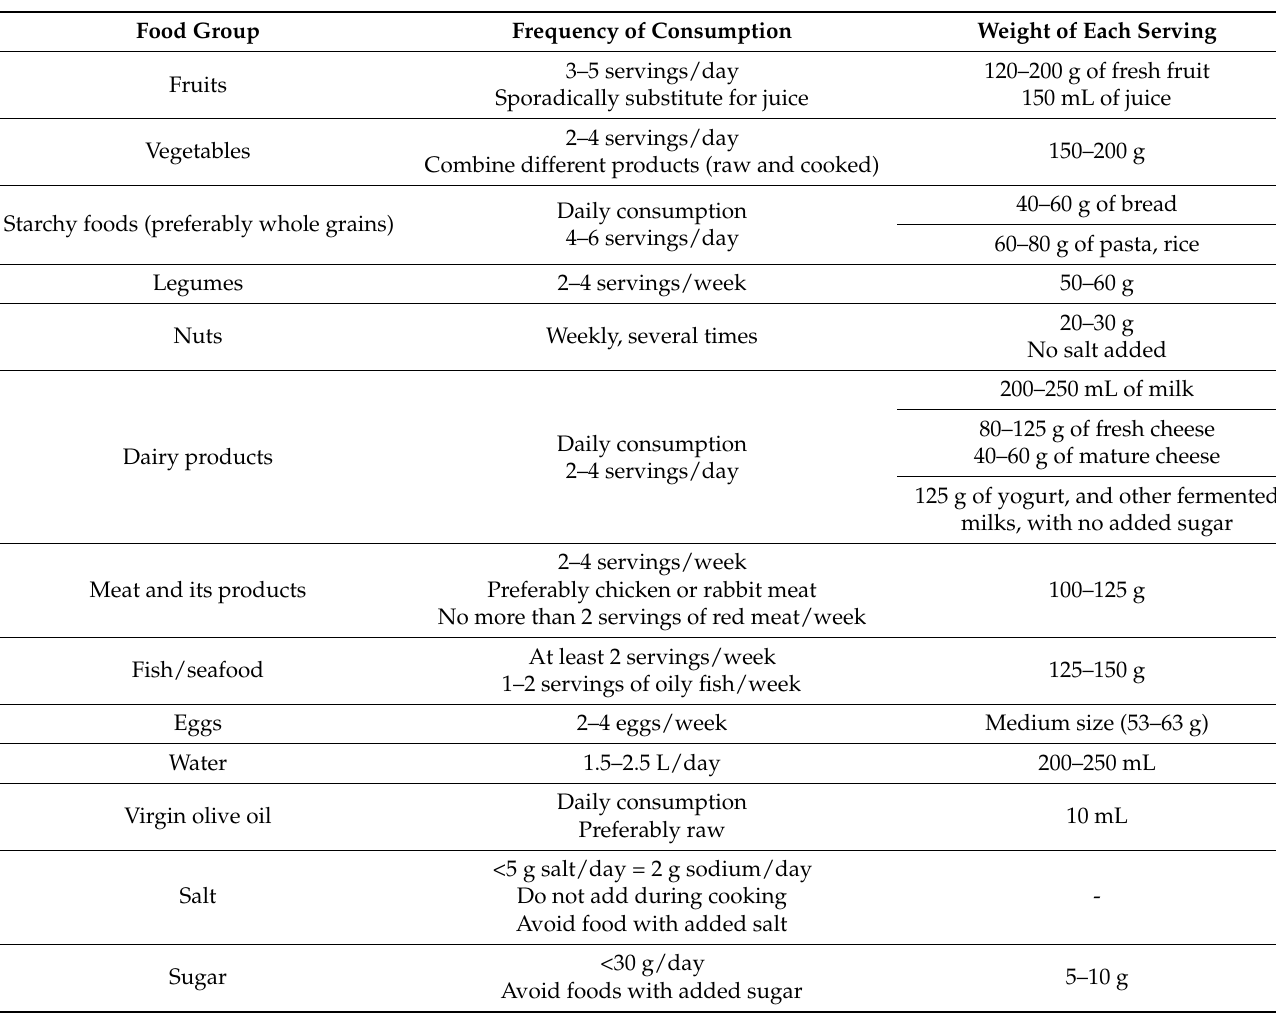
Table 7. Dietary recommendations for each food group and other important categories proposed by the Scientific Committee of AESAN. Adapted from